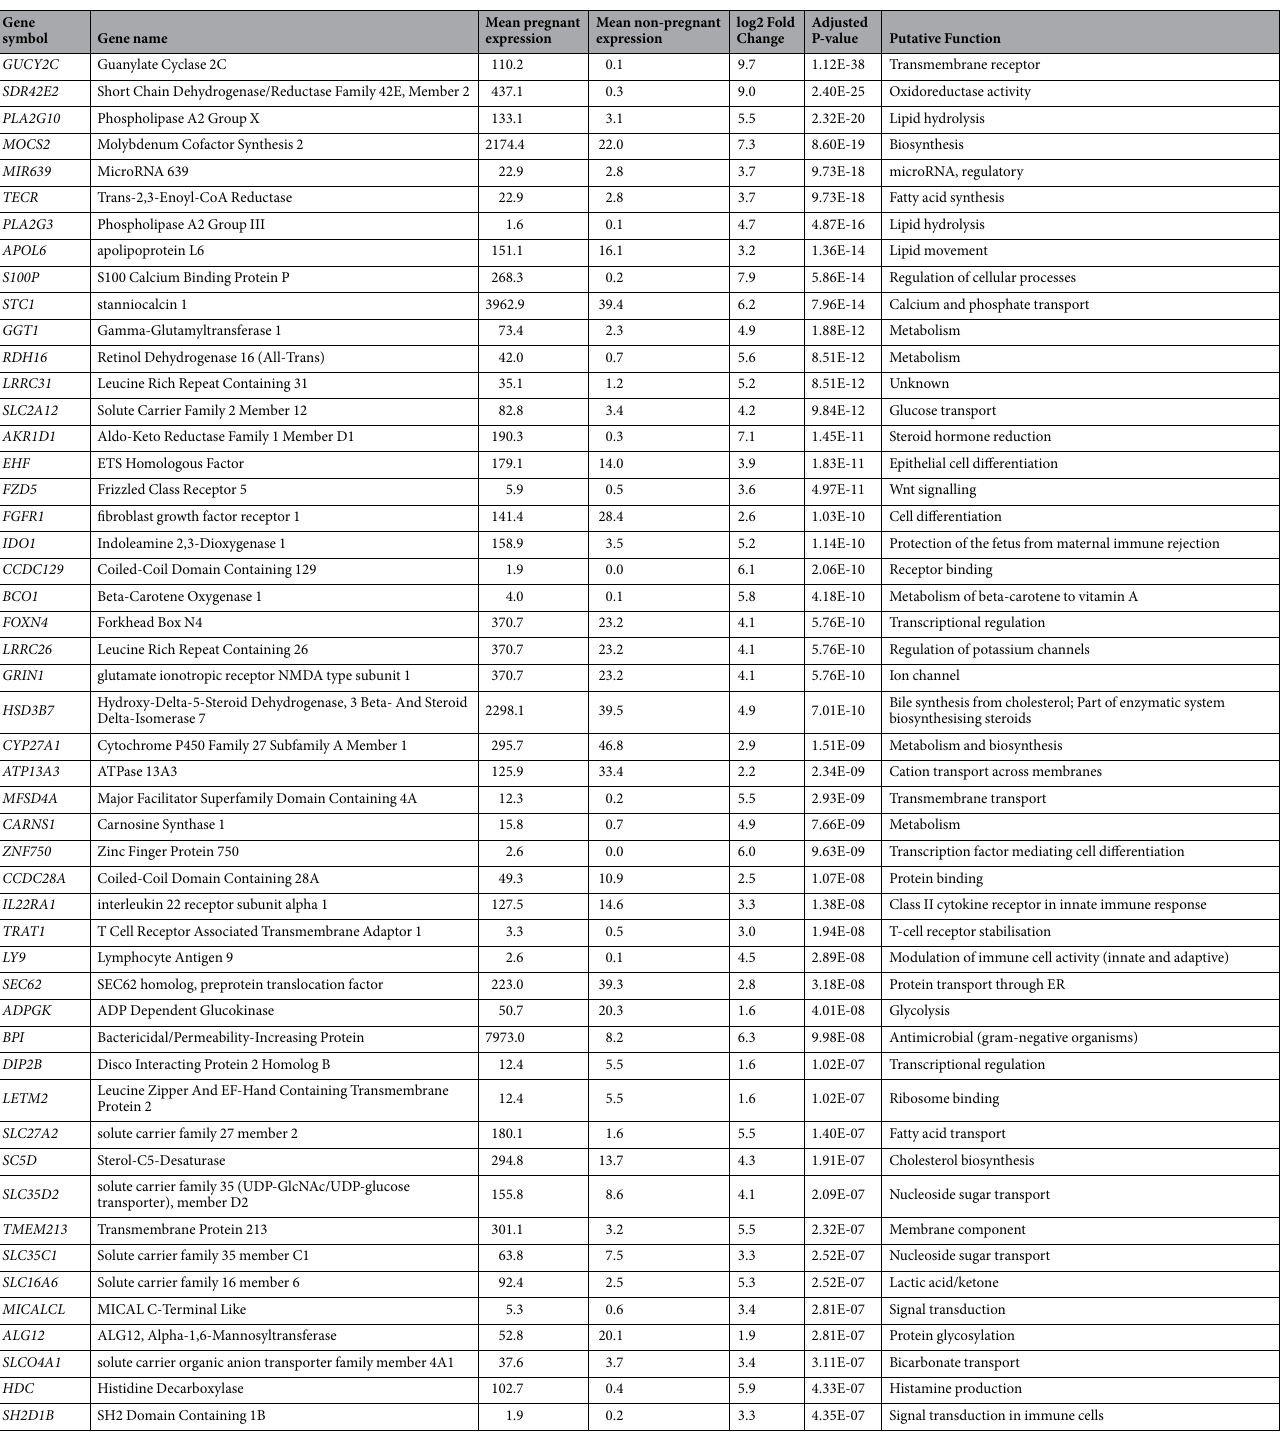
Table 1. The top 50 significantly up-regulated annotated genes during pregnancy, ranked by adjusted P-value, displaying best BLAST hit HUGO Gene Symbol, log2 ratios, and FDR‐adjusted p‐values, along with mean expression values per stage. Mean expression values are normalized transcripts per million